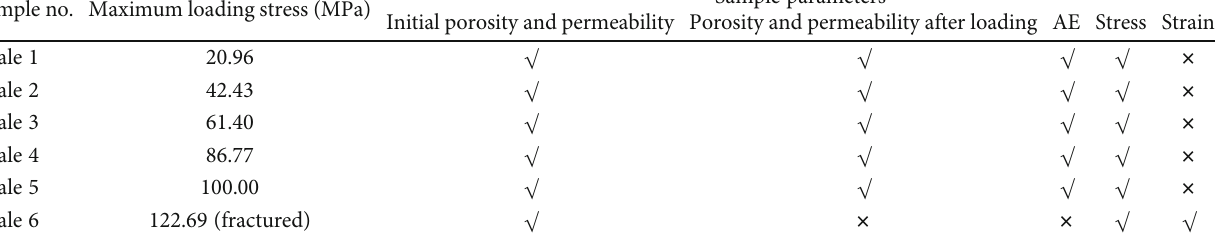
Table 2: Details of the sample parameters that got tested. Sample no. Maximum loading stress (MPa)